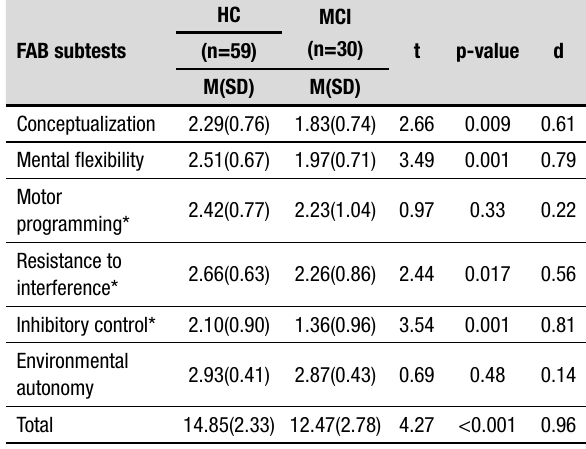
Table 2. Performance of healthy controls and mild cognitive impairment patients in the Frontal Assessment